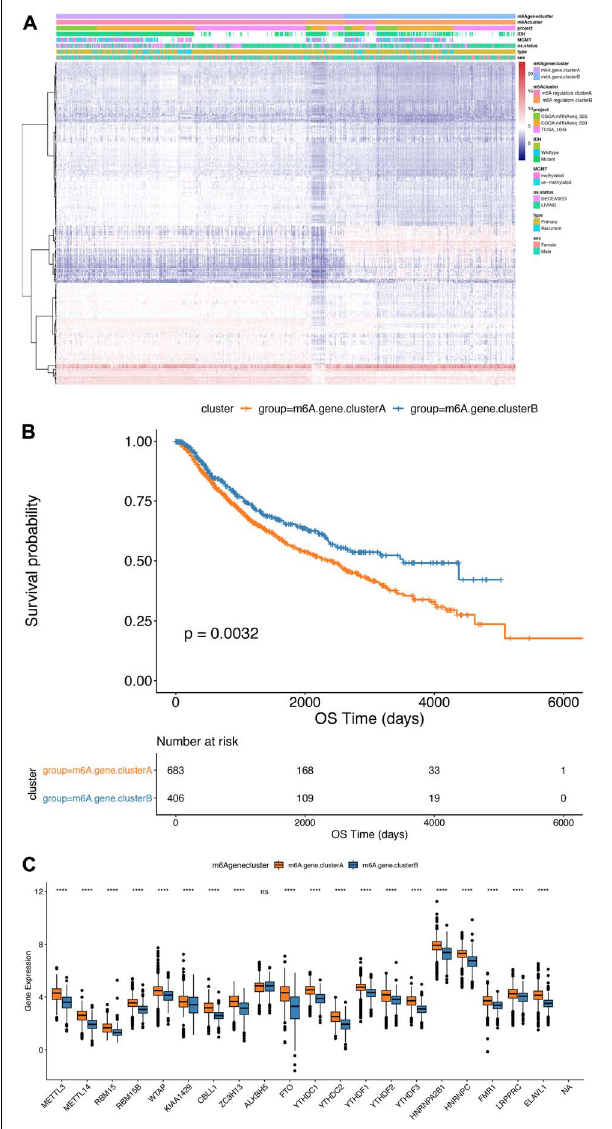
FIGURE 5 | Comparison between m6Agenecluster. (A) Unsupervised clustering of m6A phenotype-related genes in low-grade glioma samples. The samples are divided into different genomic subtypes, called m6AgeneclusterA and m6AgeneclusterB. (B) Kaplan-Meier curve indicates that m6A modifies the genome table type has an obvious relationship with overall survival rate. (C) Expression of 20 m6A genes in 2 gene clusters. The upper and lower ends of the box indicate the interquartile range of values. The line in the box indicates the median value, and the black dots indicate outliers. The t -test is used to test the statistical differences between gene clusters (**** p <